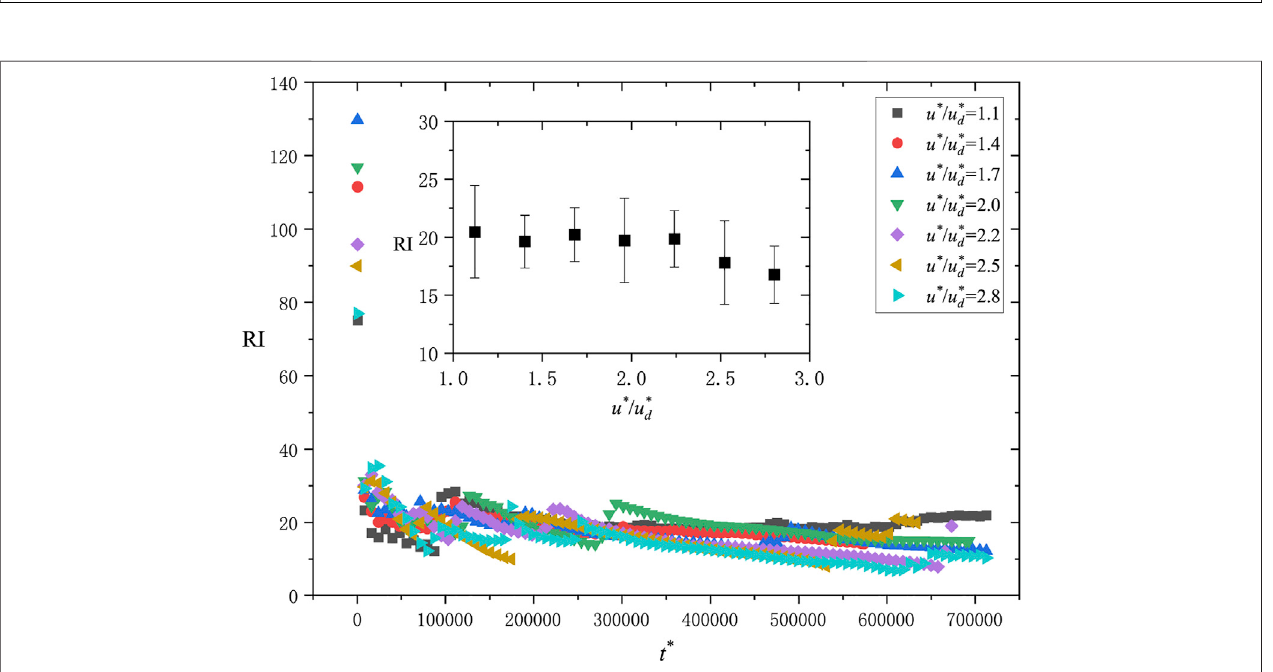
FIGURE 9 | Ripple index (RI) development versus time. The inset shows the average value of the RI during t * (cid:1) 50000 ∼ 300000 in different wind velocities.